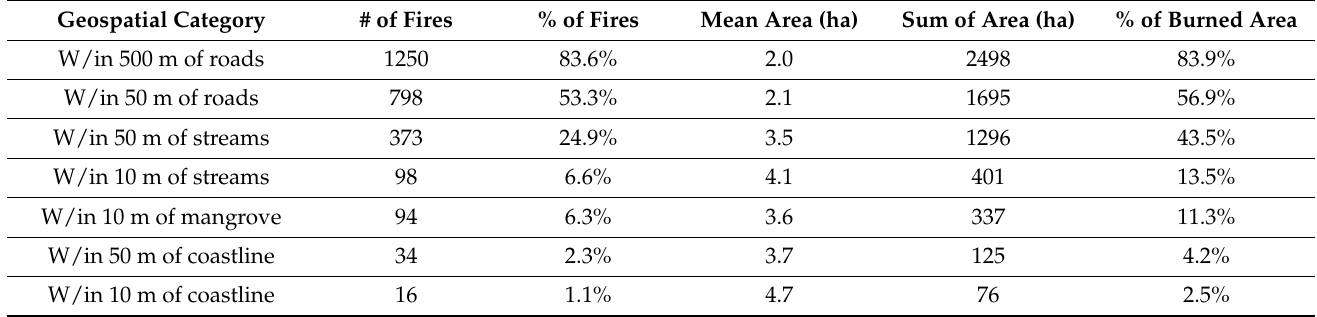
Table 7. Number and percentage of total wildfires, mean (ha), sum (ha), and percentage of total burned area by geospatial category on Babeldaob Island, Palau, from 2012 to